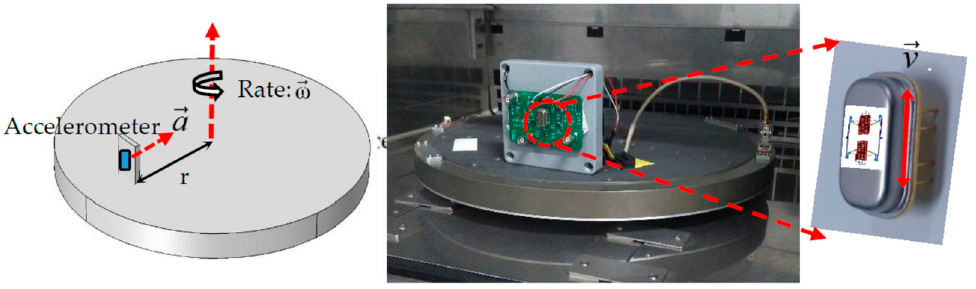
Figure 9. The sensitivity test by the rotating platform.